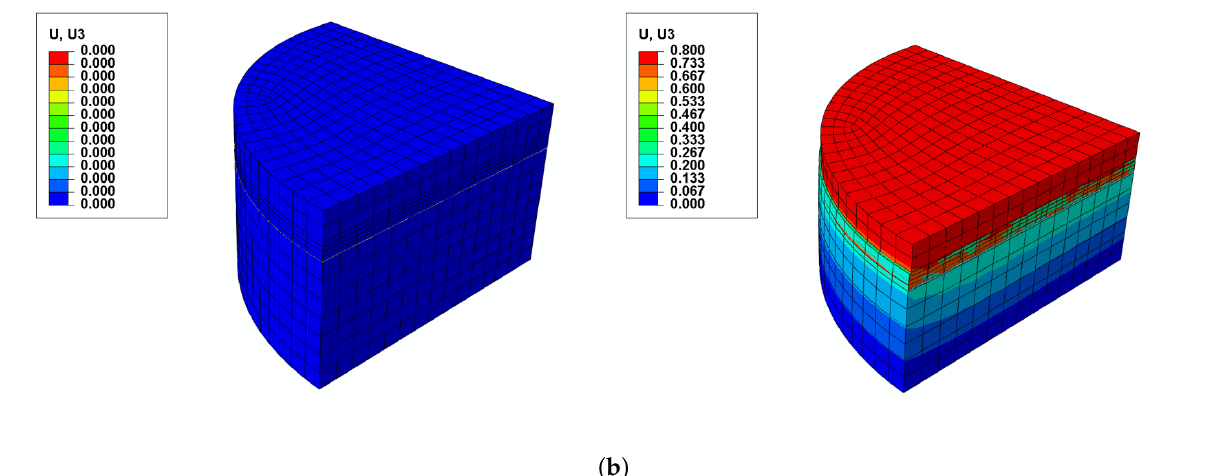
Figure 8. Model for validating the pressure-overclosure condition. ( a ) Quarter model with additional axial symmetry plane; ( b ) FE model; on the left: unloaded condition, the CFRP disk lies on the PA lamella. On the rigth: the CFRP disk is pressed into the PA lamella, and the penetration is well recognizable.